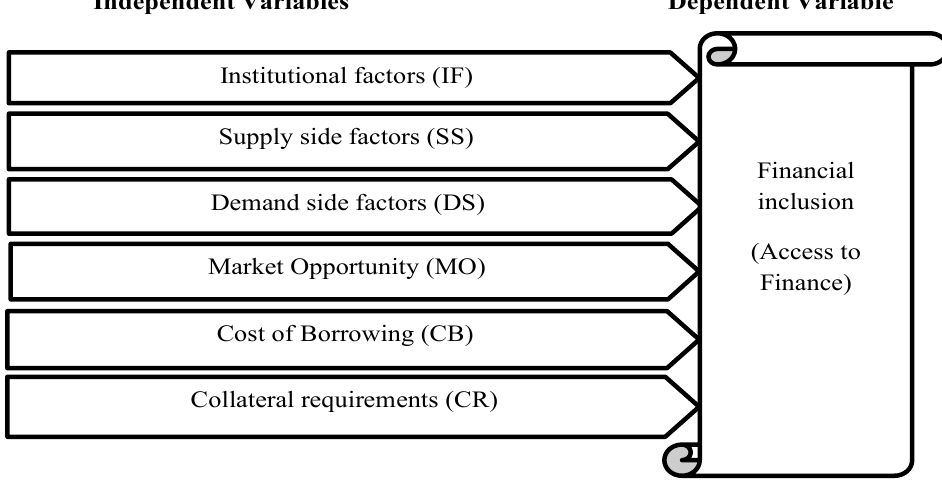
Figure 1. Research framework. Source: Authors’ own work